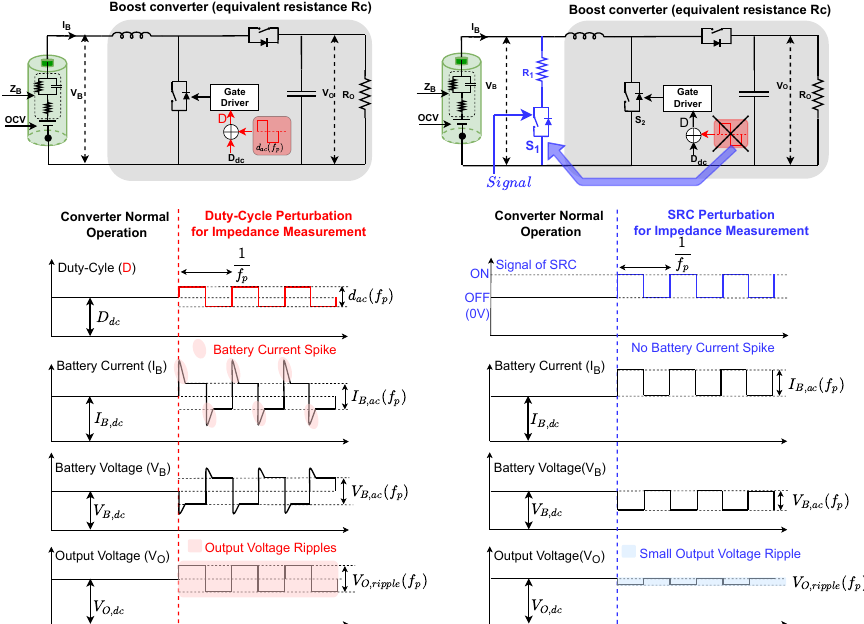
Figure 1. Illustration diagrams for battery impedance measurement methods: conventional duty cycle perturbation method (left) (Reproduced with permission from [5], IEEE, 2017) and the proposed switched resistor circuit (SRC) perturbation method